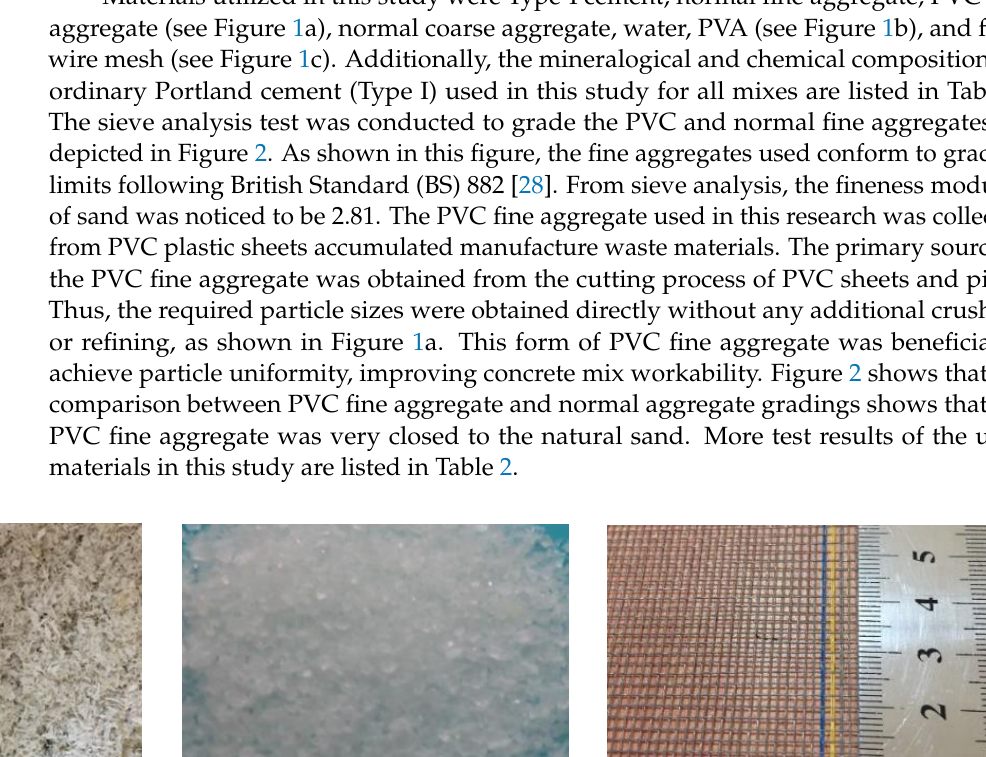
Magnesia (MgO) Loss of ignition (L.O.I)